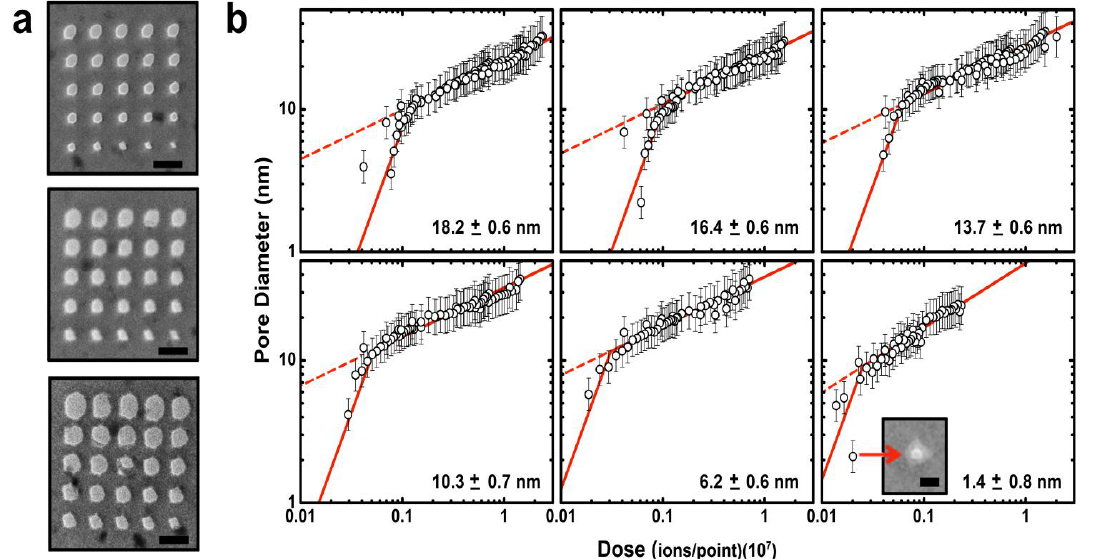
Figure 3. Solid-state nanopore expansion as a function of membrane thickness. ( a ) Transmission electron micrographs of three nanopore arrays formed in different membrane thicknesses (T-B: 18.2 ± 0.6, 13.7 ± 0.6, and 6.2 ± 0.6 nm) with the same range of He+ ion doses (0.4 − 7.1 × 10 6 ions/point). Scale bars are 50 nm; ( b ) Log-log plots of ion dose vs. resulting pore diameter over a range of membrane thicknesses, indicated in the lower right of each plot. Solid lines are power law fits to the two sections of the data. Dashed lines are continuations of the lower slope (right side) fit, illustrating the deviation from that trend at low dose. Inset (lower right) shows a transmission electron micrograph of the smallest pore (~2 nm diameter) achieved in the thinnest membrane. Scale bar is 5